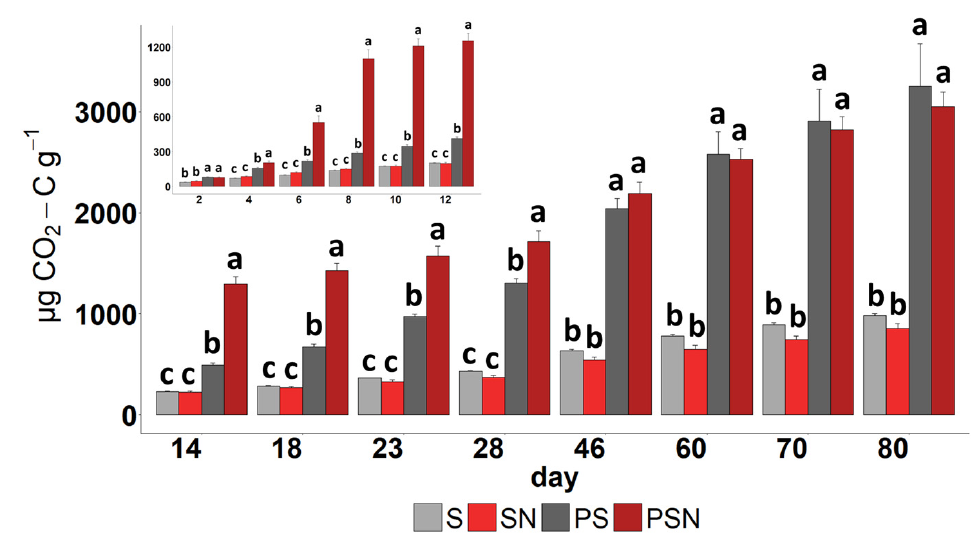
Figure 2. Cumulative amount of respired carbon during experiment. Inset figure demonstrates the first 12 days of experiment. S indicates control soil without N addition, SN—control soil with N addition, PS—PBSA-amended soil without N addition and PSN—PBSA-amended soil with N addition. Inserted figure’s units are corresponded to main figure. Different letters on the bars demonstrate significant differences between treatments within the sampling date.